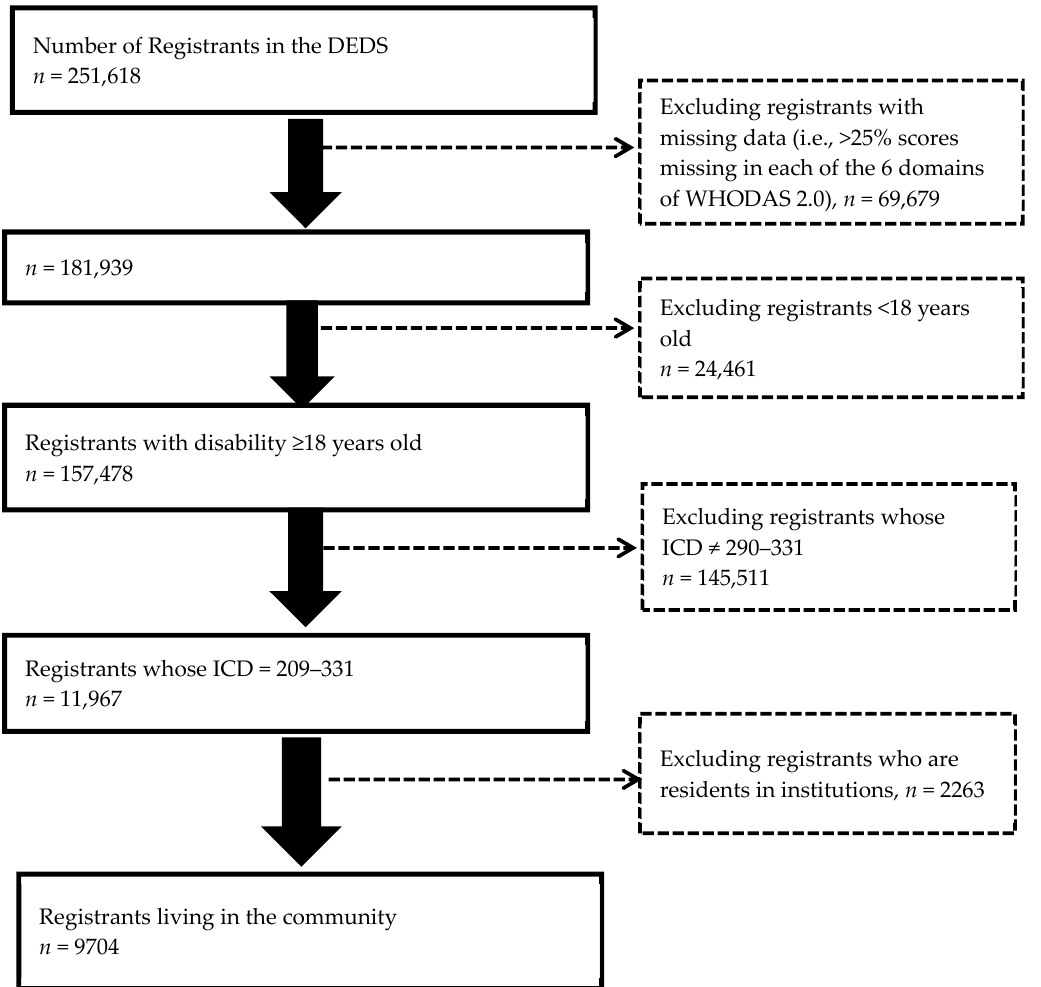
Figure 1. The sample selection process. DEDS = National Disability Eligibility Determination System (Taiwan).